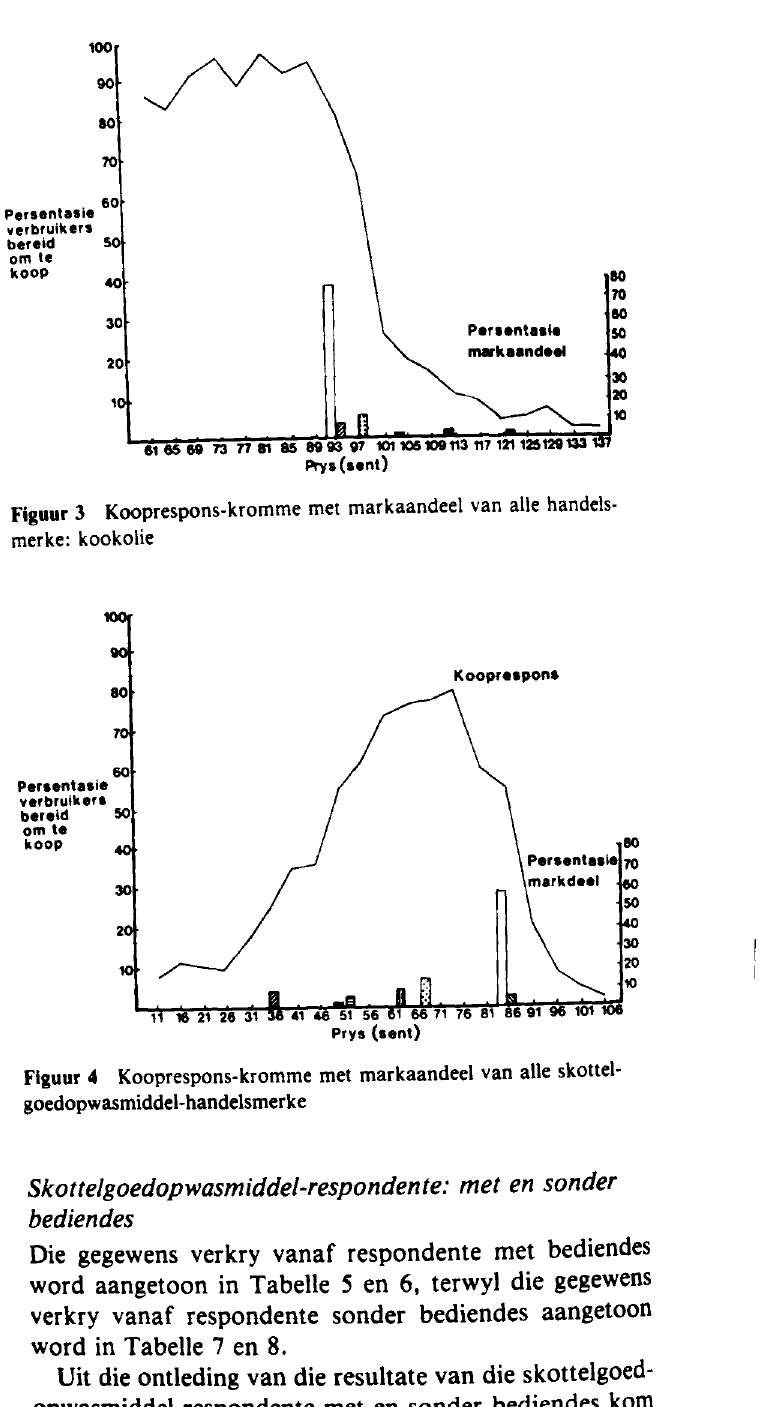
Skottelgoedopwasmiddel-respondente: met en sonder